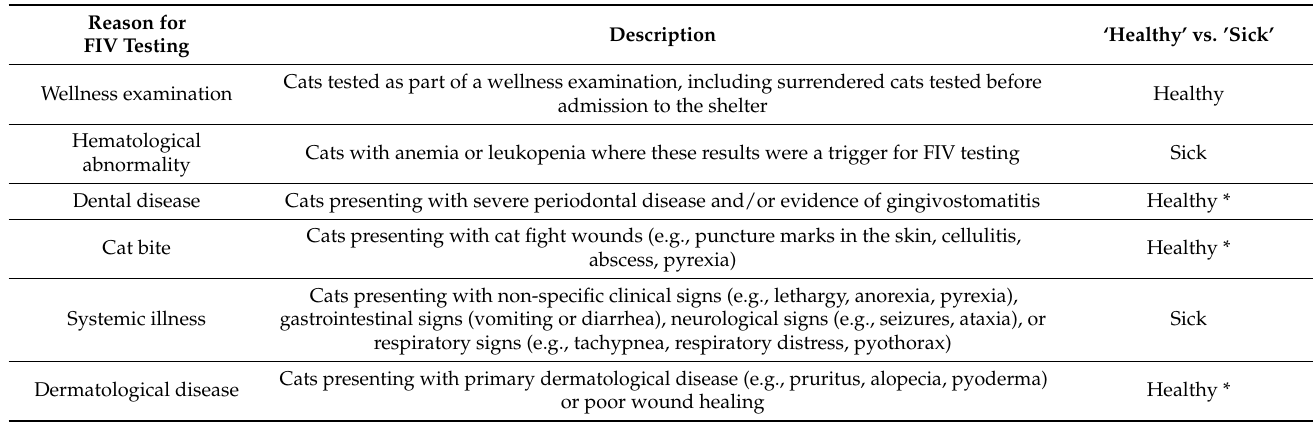
Table 2. Reasons for FIV testing in cohorts 1 and 2. Health status (i.e., ‘healthy’ vs. ‘sick’) was retrospectively assigned by the primary author